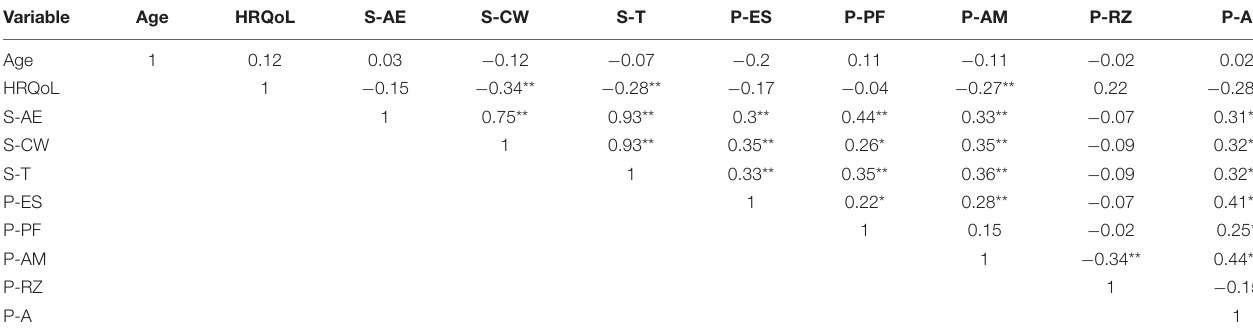
TABLE 5 | Correlations between the